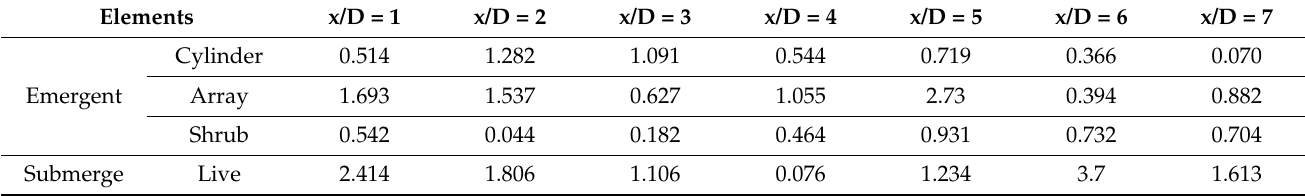
Table 3. The number of impulses that exceeds critical level during one-second duration ( f ) at the seven measurement positions for different vegetation